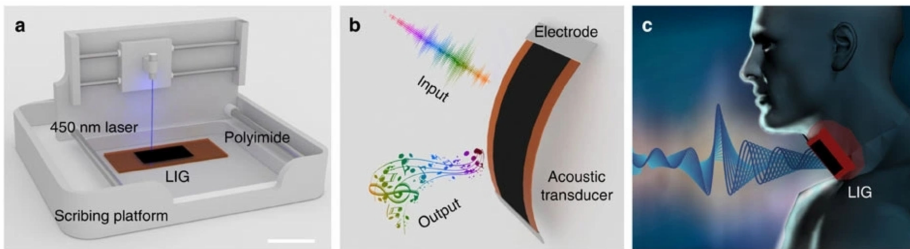
Figure 13. Intelligent artificial throat based on LIG. ( a ) One-step fabrication process of LIG. PI is directly converted into LIG by the irradiation of the 450nm laser. Scale bar, 2.5cm. ( b ) LIG has the ability of emitting and detecting sound in one device. ( c ) The artificial throat can detect the movement of throat and generate controllable sound, respectively. Reproduced with permission from [28]. Copyright 2017 Springer